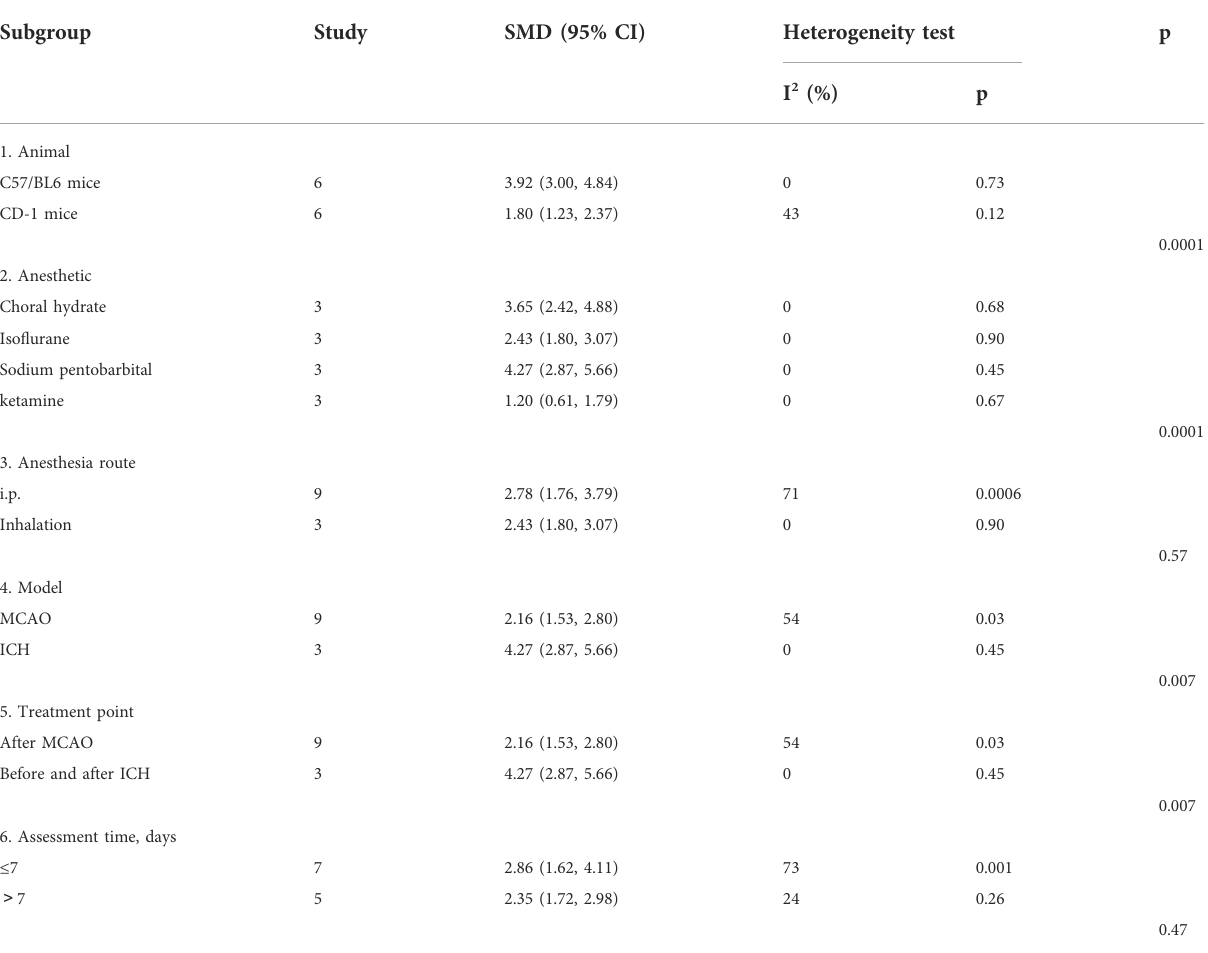
TABLE 6 Strati fi ed meta-analysis of the rotarod test.